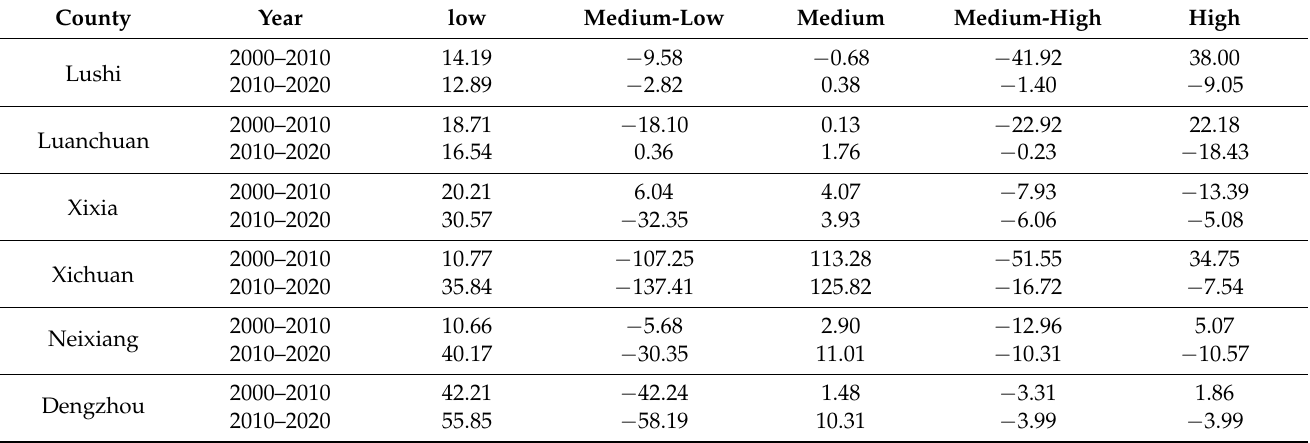
Table 7. Changes of habitat quality area in different grades of counties (unit: km 2